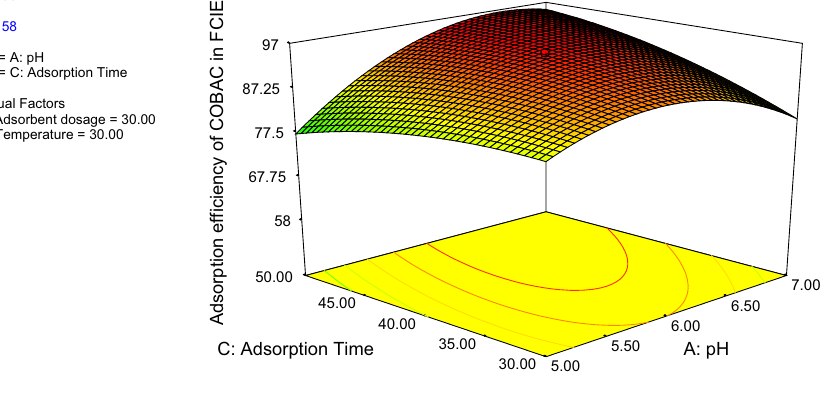
Fig. 5 3D plot showing the effect of pH and adsorption time on adsorption efficiency in the treatment of fibre cement indus- try effluent using coal-based